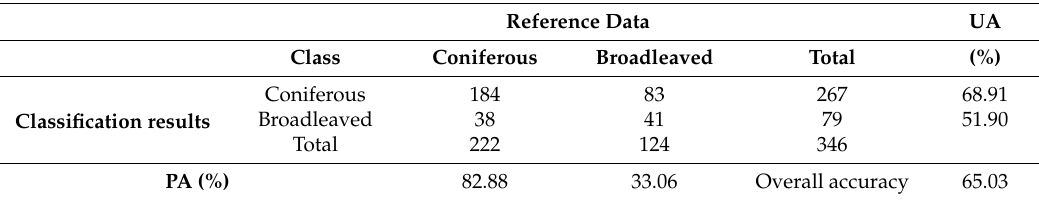
Table 5. Error matrix of tree species classification for overstory